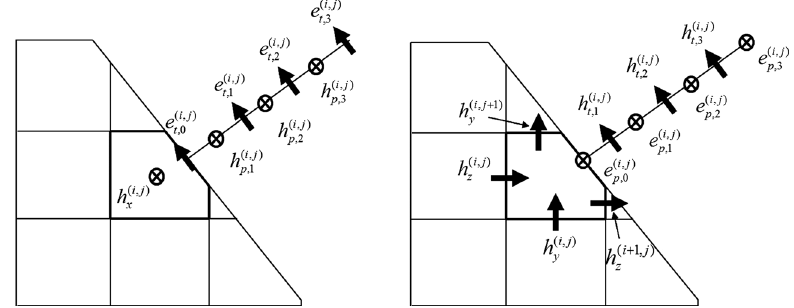
FIG. 6. A boundary cell in the vacuum and 1D conductive line in the